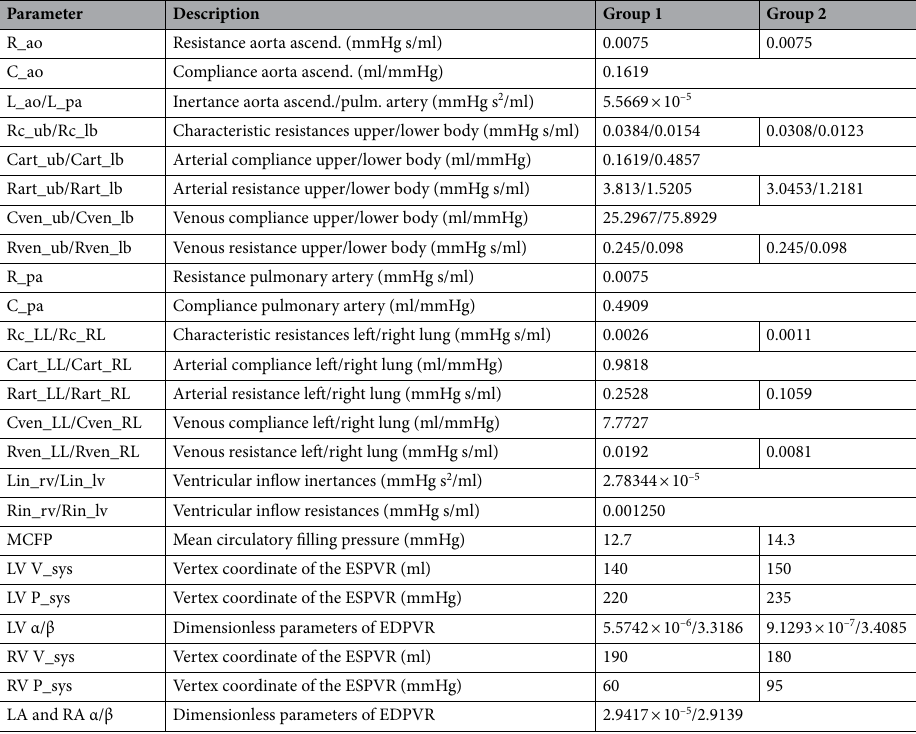
Table 2. Values of parameters of the numerical model to achieve the typical resting hemodynamic condition. Q flow rate in ml/s, LV left ventricle, RV right ventricle, LA left atrium, RA right